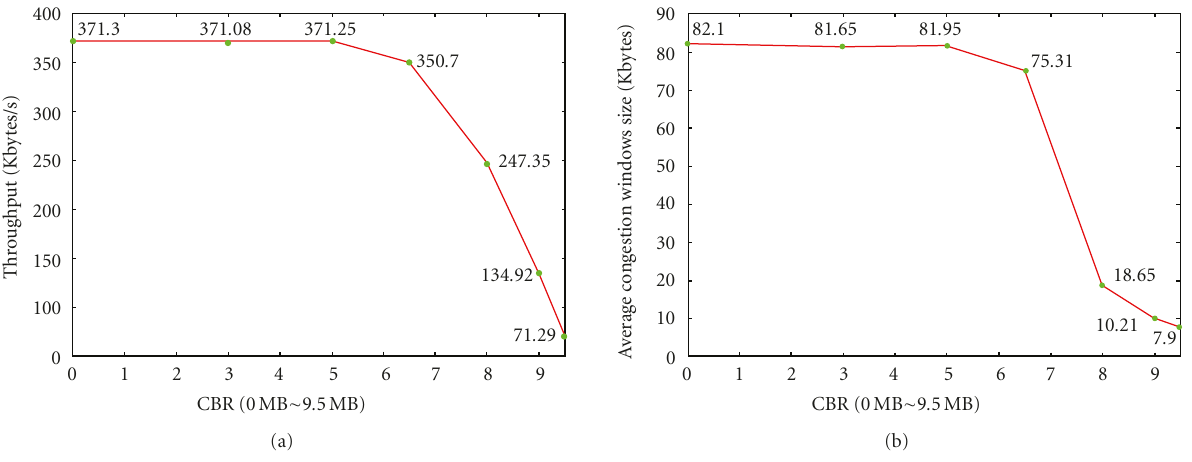
Figure 12: Impact of path congestion on SCTP